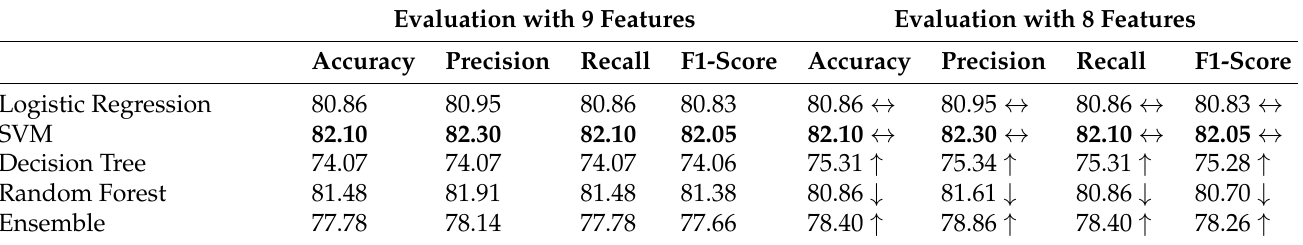
Table 2. Performance evaluation of the HbA1c-labeled dataset.